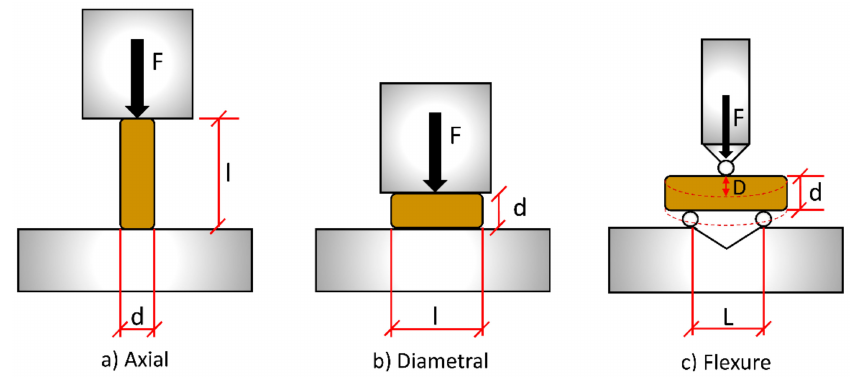
Figure 1. Axial ( a ), diametral ( b ), and flexure ( c ) mechanical test